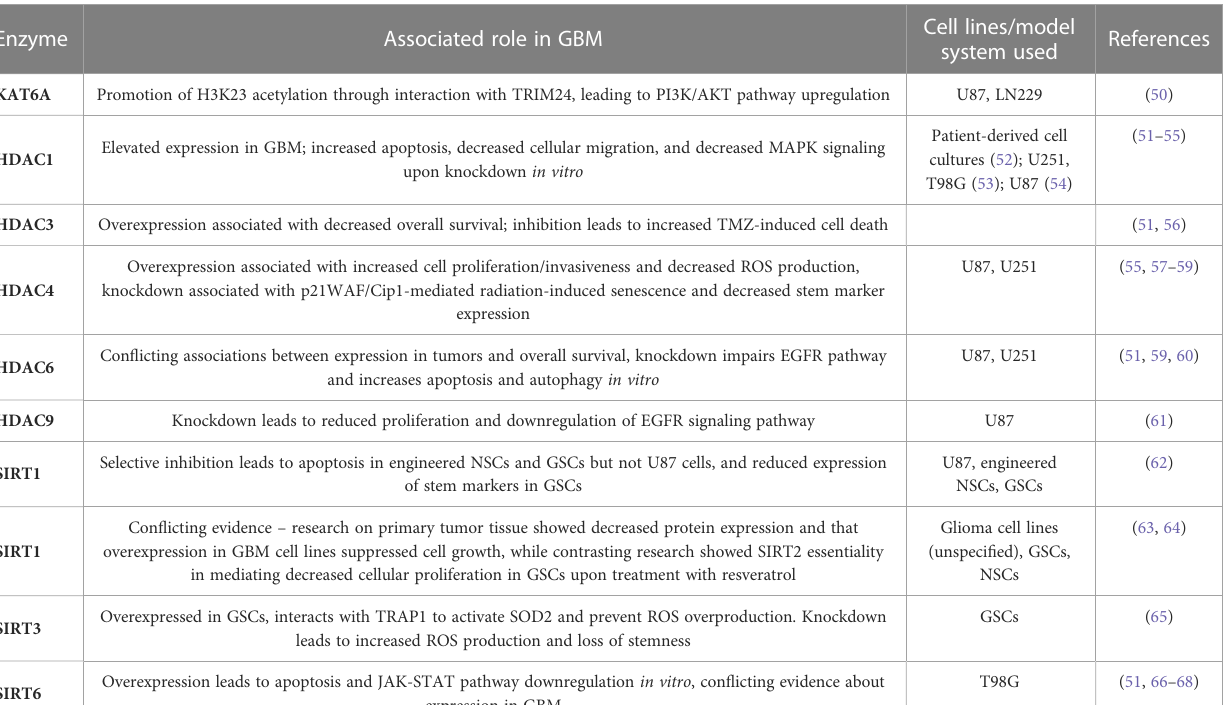
TABLE 1 The function of histone acetyltransferases & histone deacetylases in GBM.